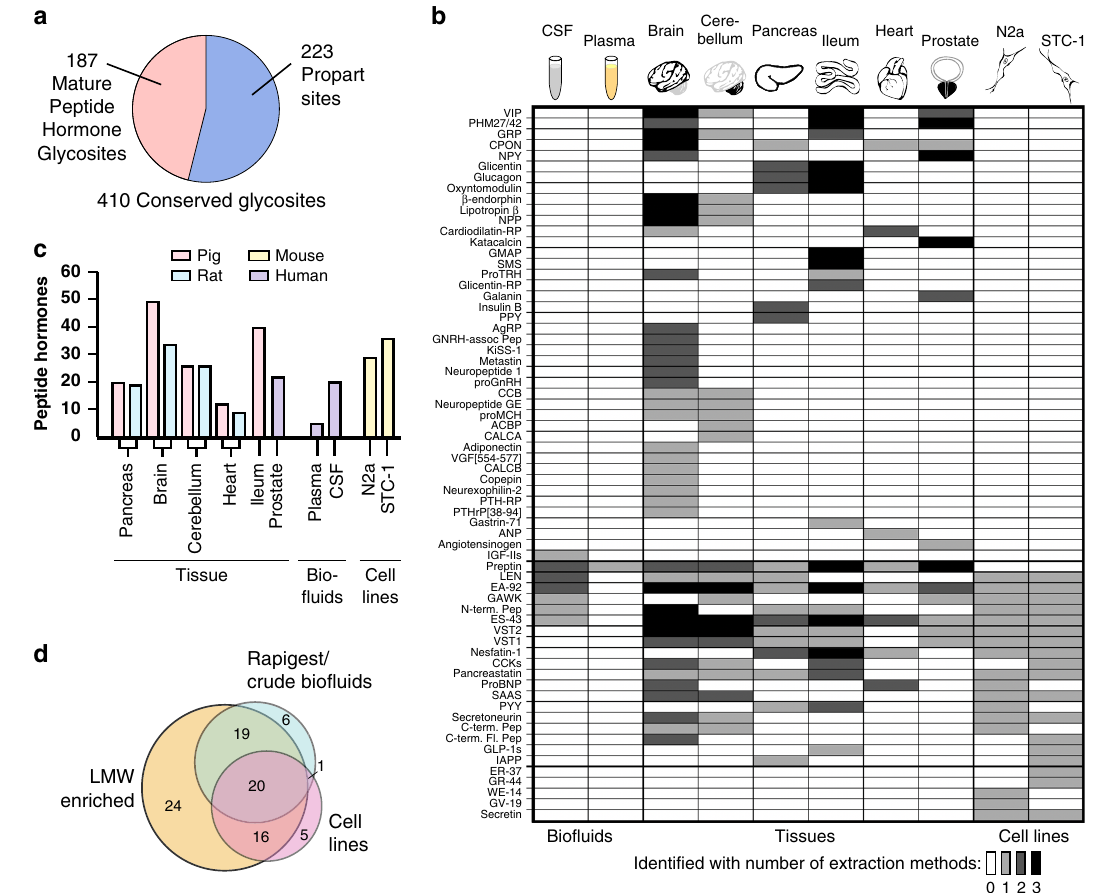
Fig. 1 Summary of the identi fi cation of glycosylated peptide hormones using LC – MS/MS. a Number of glycosites identi fi ed on mature and propeptide hormone proteins. b Heatmap illustrating the identi fi cation of glycans on mature peptide hormones across different bio fl uids, tissues, and cell lines. Greyscale intensity illustrates the number of extraction methods that have resulted in the identi fi cation of a given glycopeptide. See Supplementary Data 4 for examples of extracted spectra of glycopeptides from each peptide hormone. c Bar graph of the total number of mature glycopeptide hormones identi fi ed in each tissue or cell line (all enzymatic digestion procedures combined). d Venn diagram illustrating the distribution of identi fi ed glycosylated peptide hormones across biosources between the different extraction methods (total protein extractions (Rapigest extractions and crude bio fl uids), low molecular weight extractions (LMWE: H 2 O, acetone, acetone/AcOH, AcOH, and EtOH/HCl) and cell lines (supernatant and total cell lysate)). Please see Supplementary Data 1 for peptide hormone